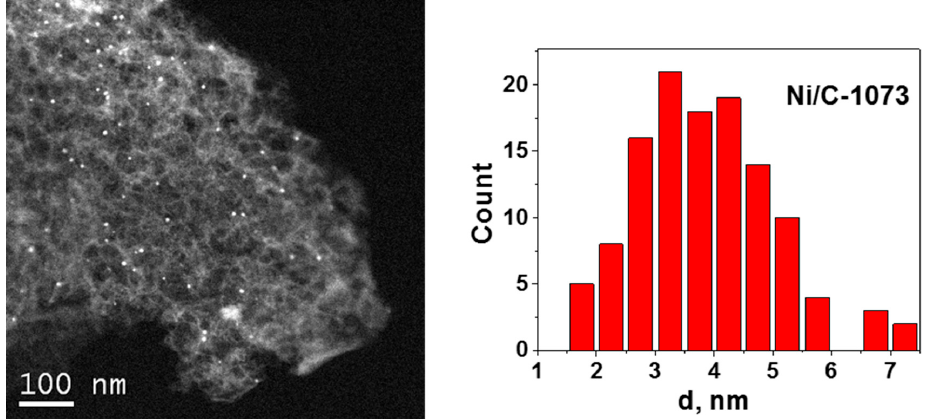
Figure 2. High angle annular dark field / scanning TEM (HAADF / STEM) image of the Ni / C-1073 catalyst after the reaction and Ni particle size distribution for this sample.